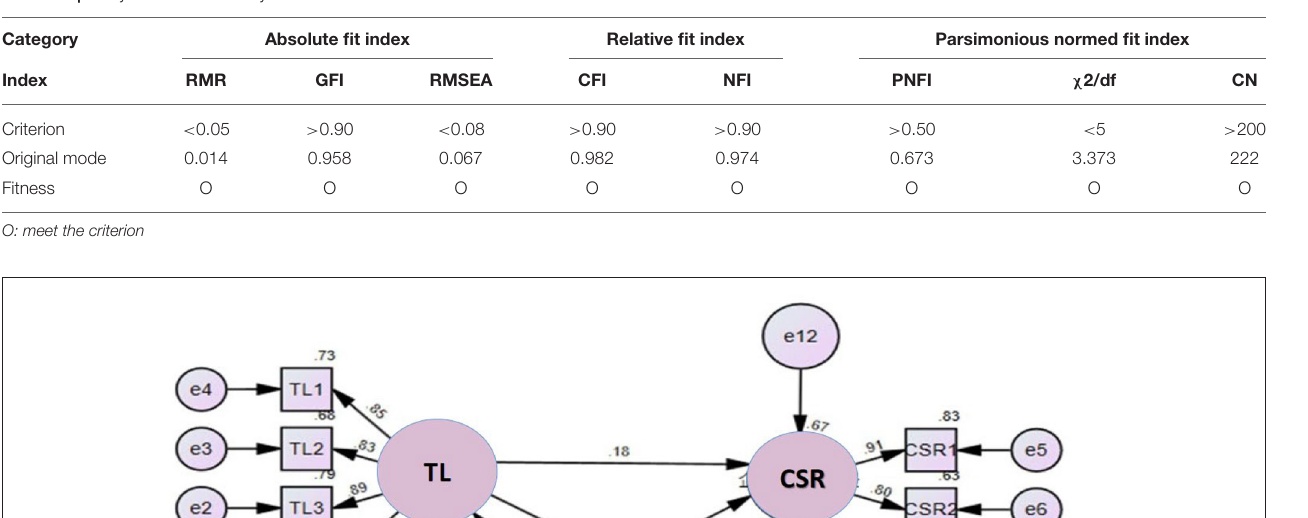
suggested by Hair et al. (2009). This means that the model has no violation of the estimation and a final discussion and analysis can be implemented. The results in Table 3 show that the absolute, relative and parsimonious fit indices are all good, i.e., the model achieves good